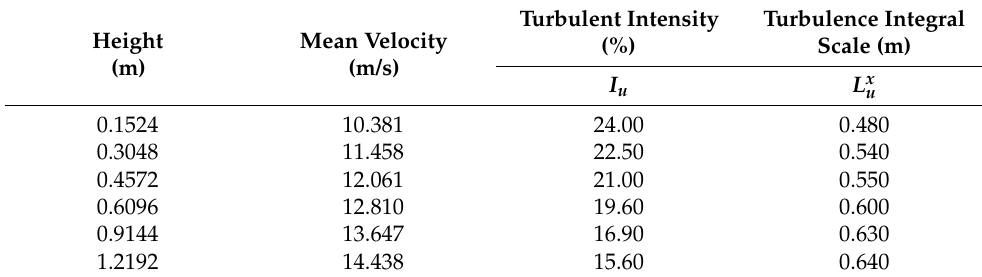
Table 2. Measured inflow wind characteristics of the rural terrain.